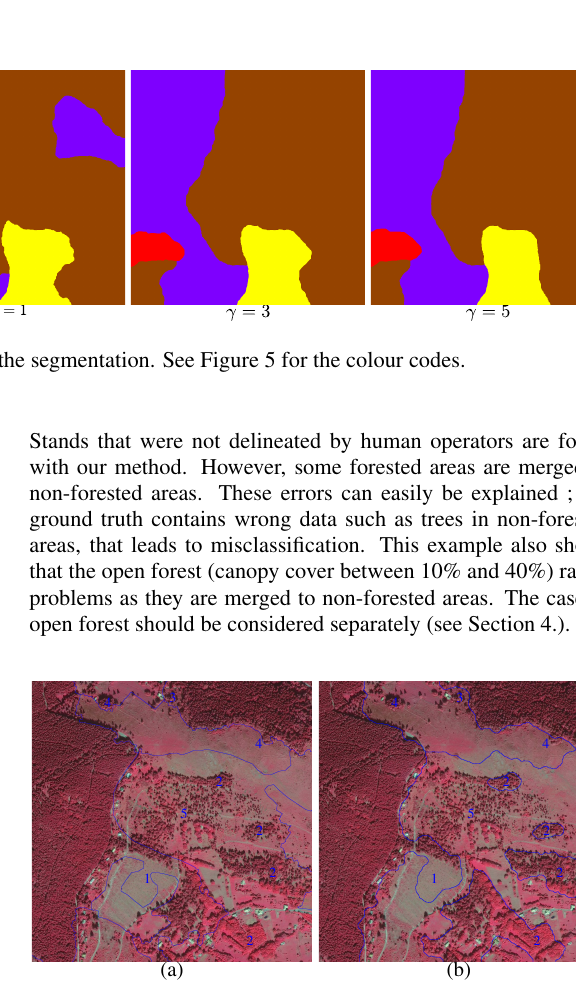
Figure 11. Delineation of the stands (in blue) superposed to the IRC orthoimage (area 7 in Figure 13). (a) Delineation by human operator. (b) Automatic delineation. 1 : training error, 2 : new